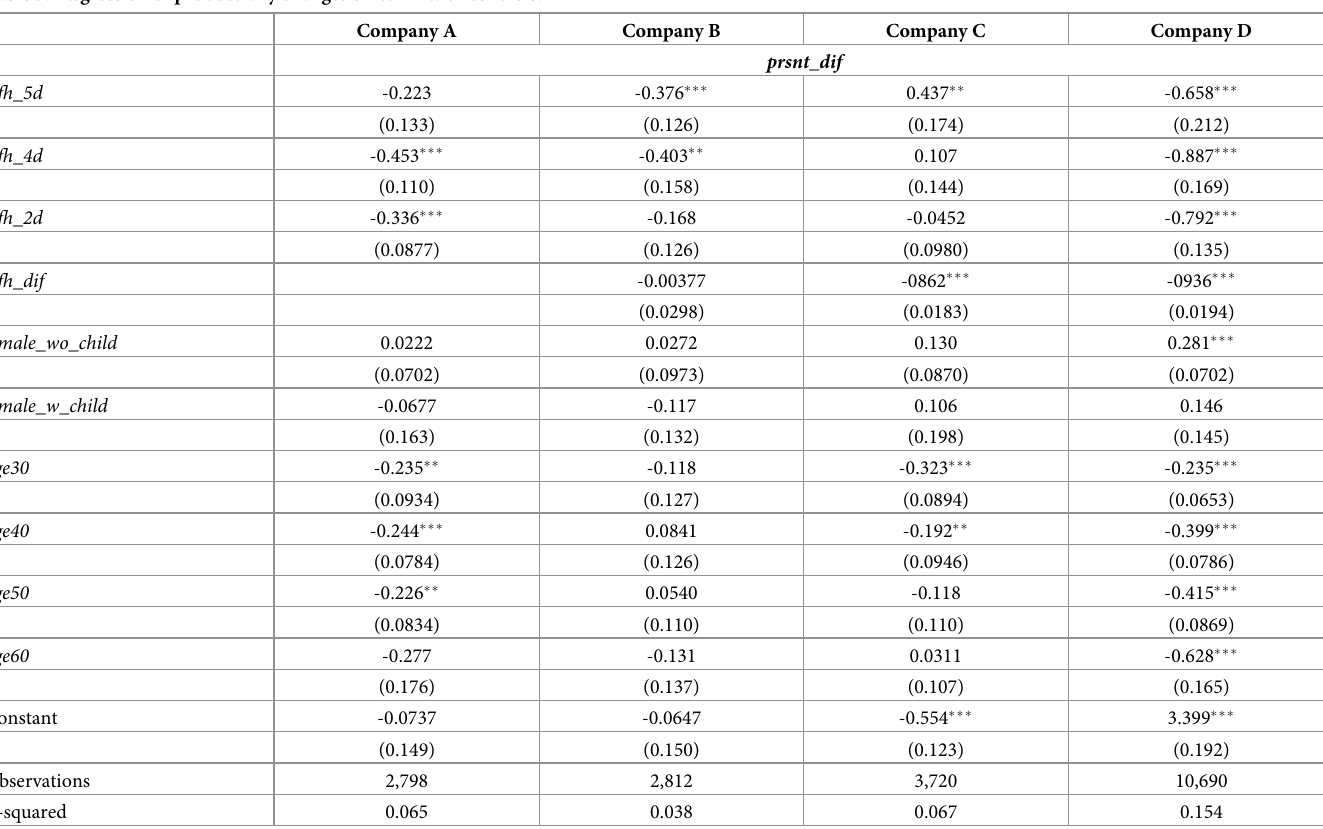
Table 3. Regression of productivity changes on WFH with